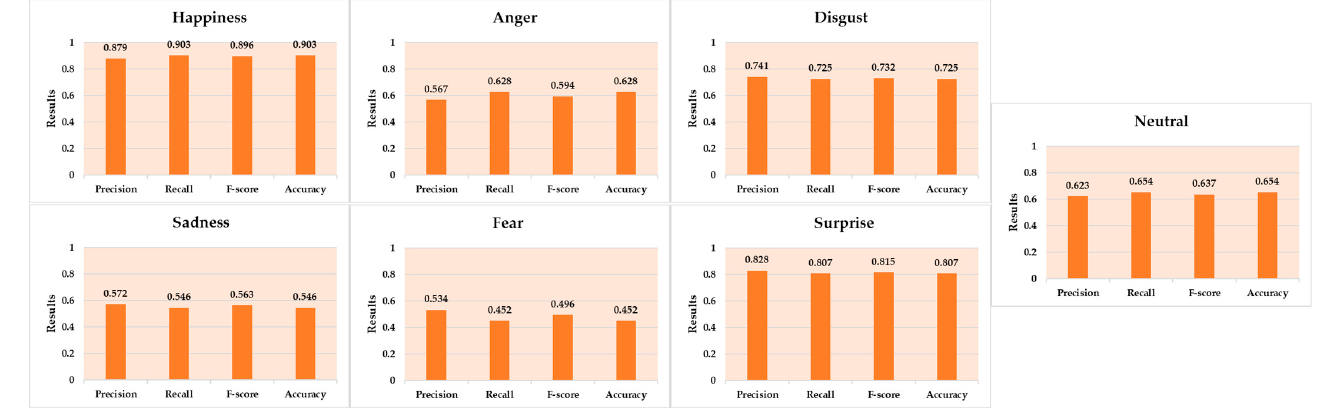
Figure 12. Evaluation results of the seven emotions for the proposed method on the AffectNet dataset.